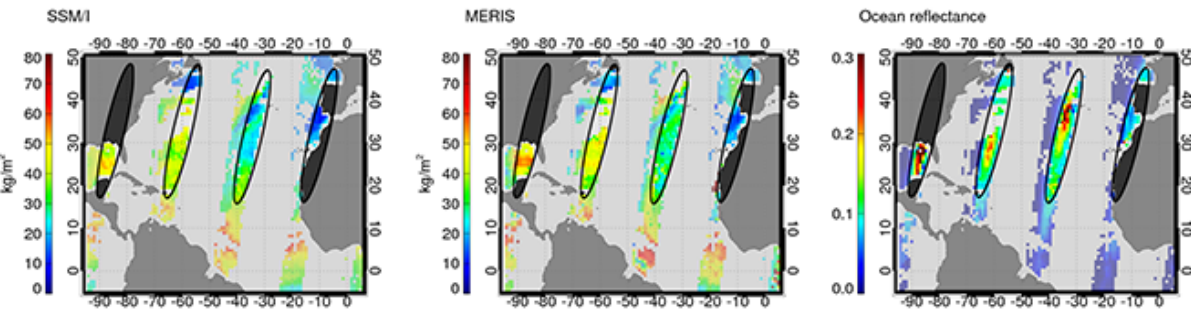
Figure 7. Close-up of daily composites of TCWV from SSM/I (left) and MERIS (middle) over ocean and ocean surface reflectance at 900nm for MERIS viewing geometry (right), on 9 July 2007. Plots only show data where both MERIS and SSM/I retrievals are valid. Unshaded elliptic areas indicate regions where MERIS retrieval is reliable.